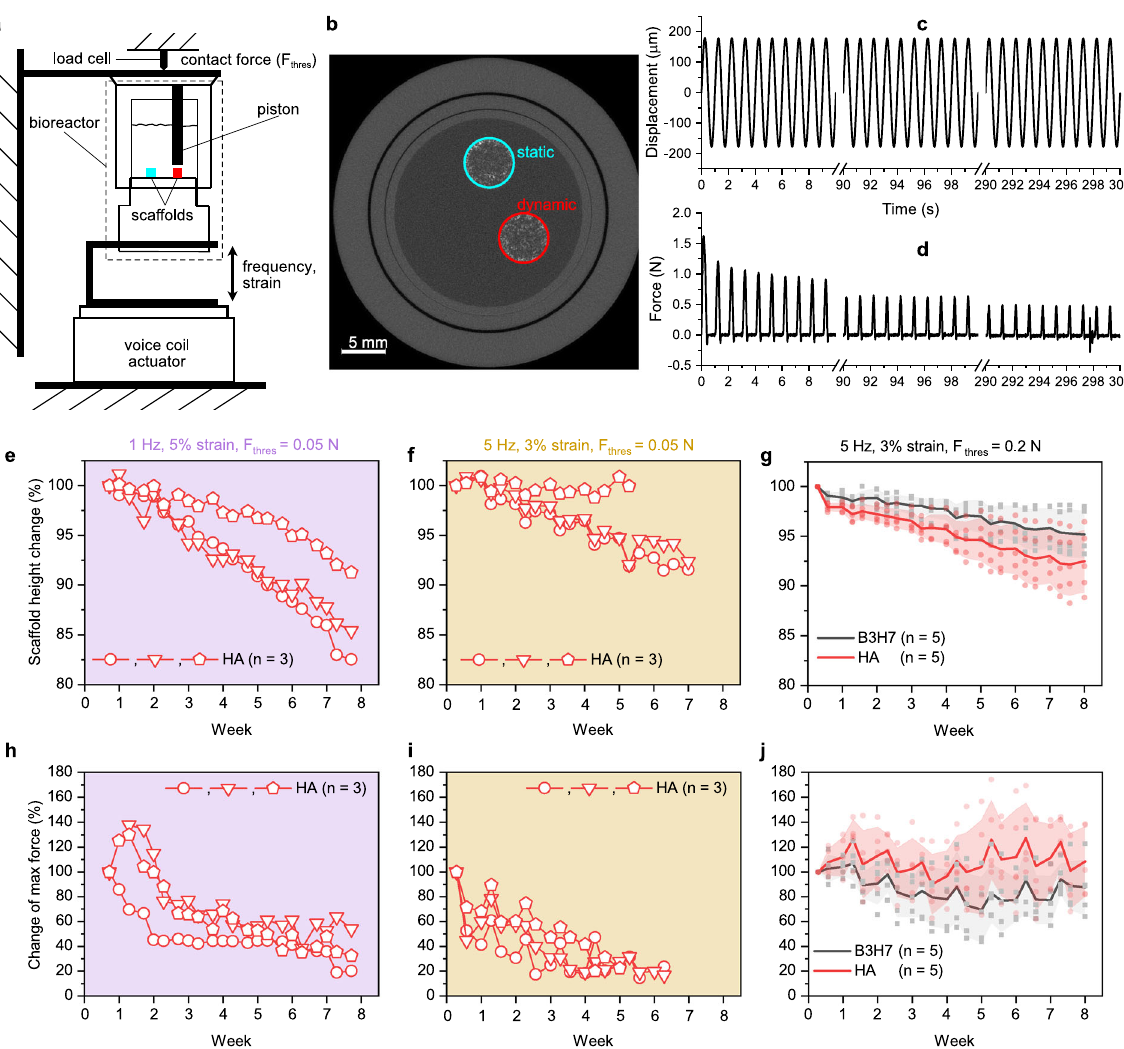
Fig. 2 Monitoring of cell-seeded scaffolds in dynamic compression bioreactors. a Scheme of two scaffolds fi xed inside the bioreactor 40 . The red scaffold is loaded cyclically. b Raw micro-CT image of the bioreactors showing the two scaffolds. c Displacement recording during cyclic compression with 1 Hz, and 5% strain and d the corresponding force recording. Height change of scaffolds containing pure hydroxyapatite (HA) and a mixture of barium titanate and hydroxyapatite (B3H7) during dynamic culture with 1 Hz, and 5% strain ( e ), 5 Hz, 3% strain ( f ), both with F thres = 0.05 N, the latter also with F thres = 0.2 N ( g ). h – j The corresponding change of max. force response. Symbols represent data points, bold lines the mean and shaded areas the s.d. No signi fi cant difference was found between B3H7 and HA scaffolds on the last day; p > 0.05;